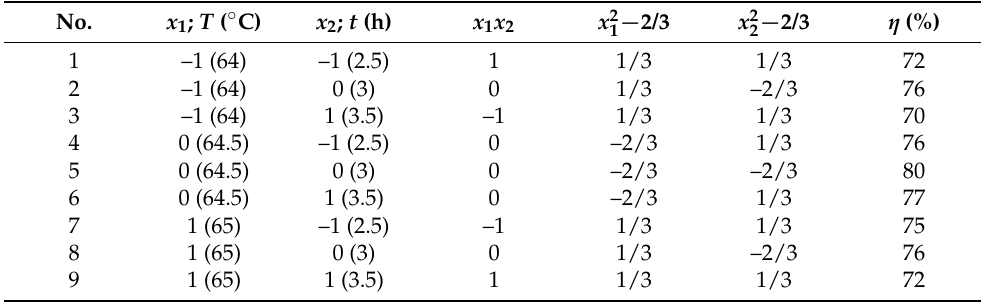
Table 1. Dimensionless variables and the measured reaction’s yield for obtaining the compound V .